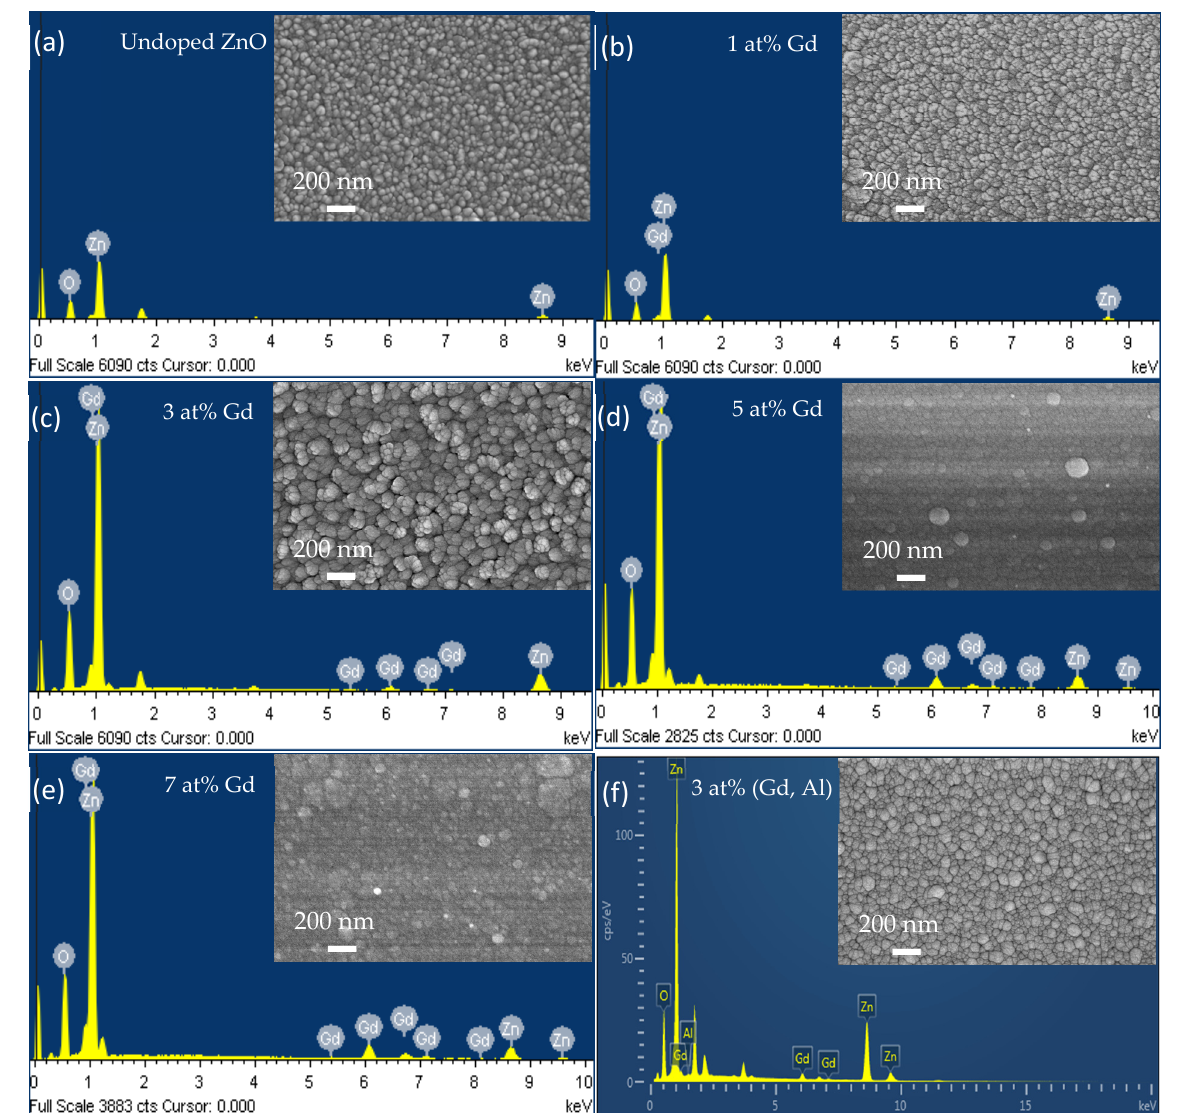
Figure 3. EDX spectrum of ( a ) undoped ZnO, ( b – e ) Gd-doped ZnO film at various Gd concentrations, and ( f ) 3 at% (Gd, Al) co-doped ZnO films. The inset figure shows the FESEM.